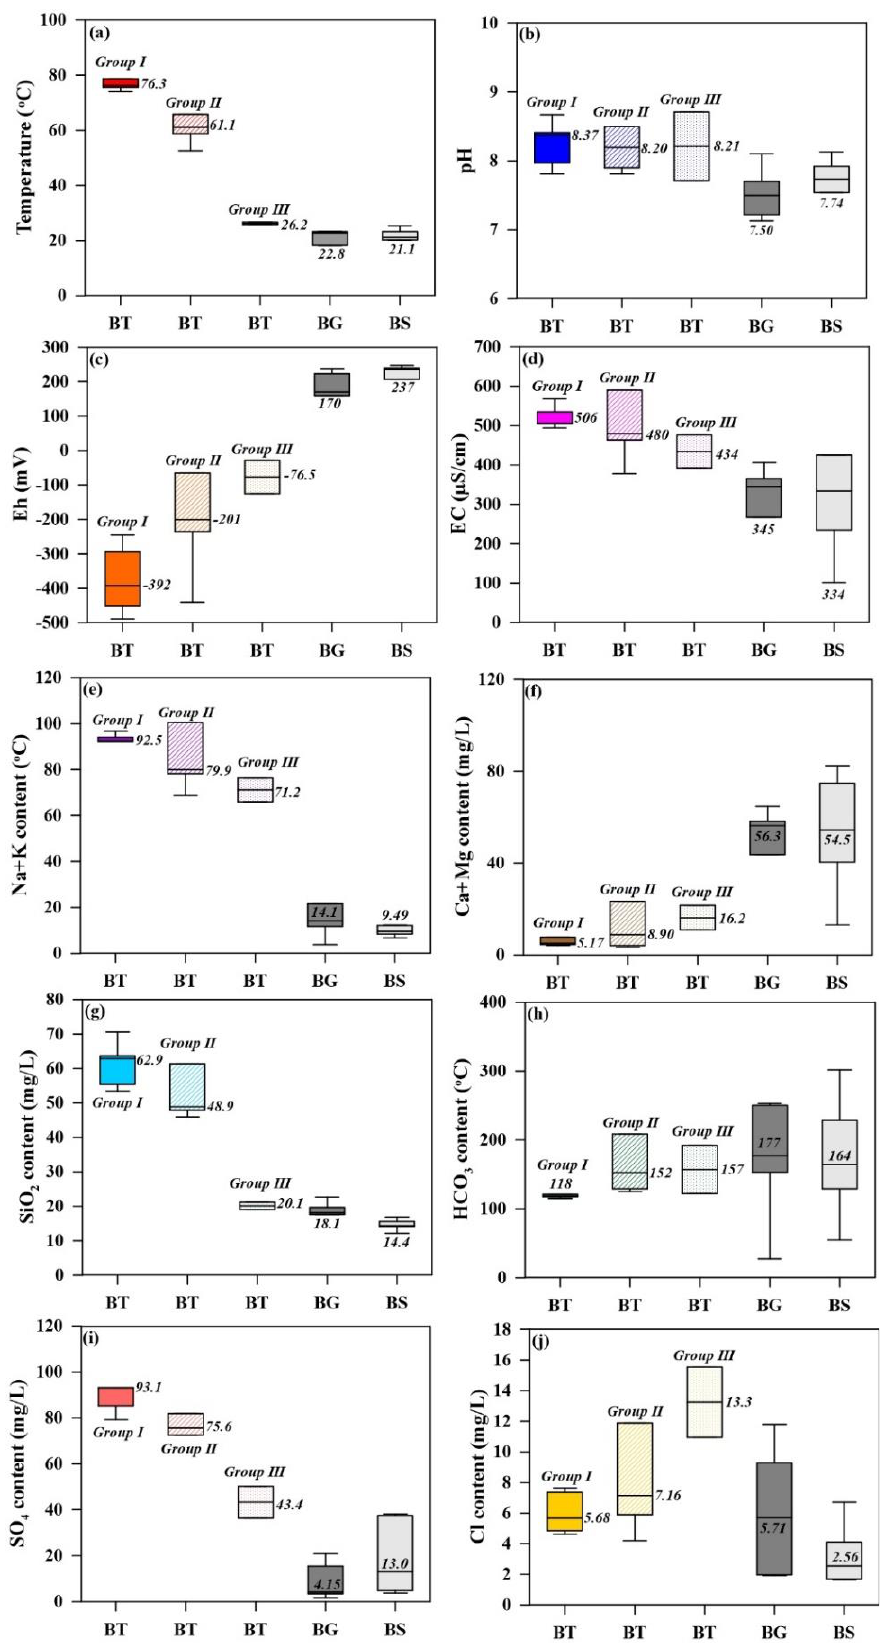
Figure 3. Box-whisker plot of temperature ( a ), pH ( b ), Eh ( c ), EC ( d ) and major ions( e − j ) of the thermal water (BT), groundwater (BG), and stream water (BS).